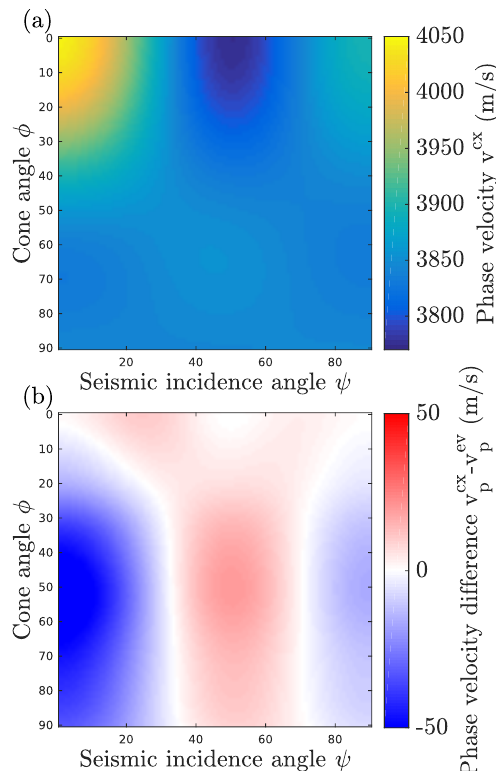
Figure 3. (a) P-wave velocity v cx p for cone fabric from randomly generated c axes. (b) Difference in P-wave velocity between the two frameworks for cone fabric. Blue shows where the ev framework ob- tains higher velocities than the cx framework. Red indicates the op- posite. They differ by − 50 to 20ms − 1 (corresponding to ≤ 1 .